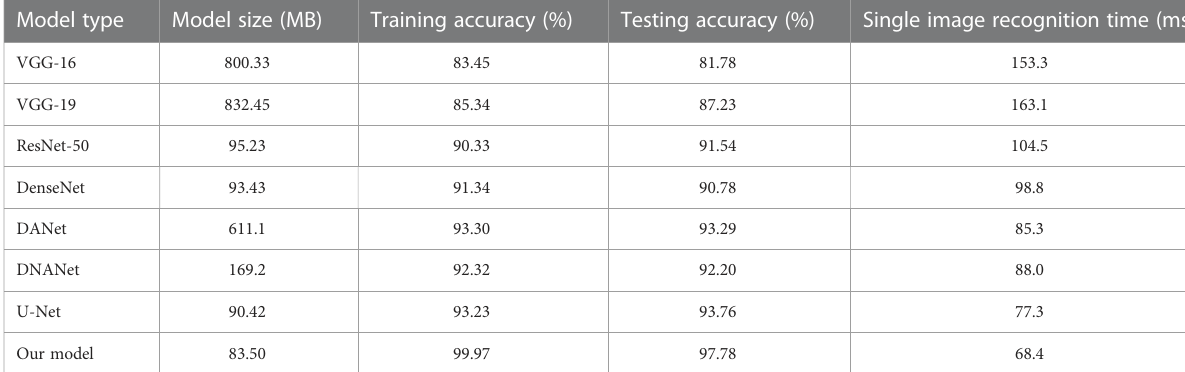
TABLE 2 Experimental results for each